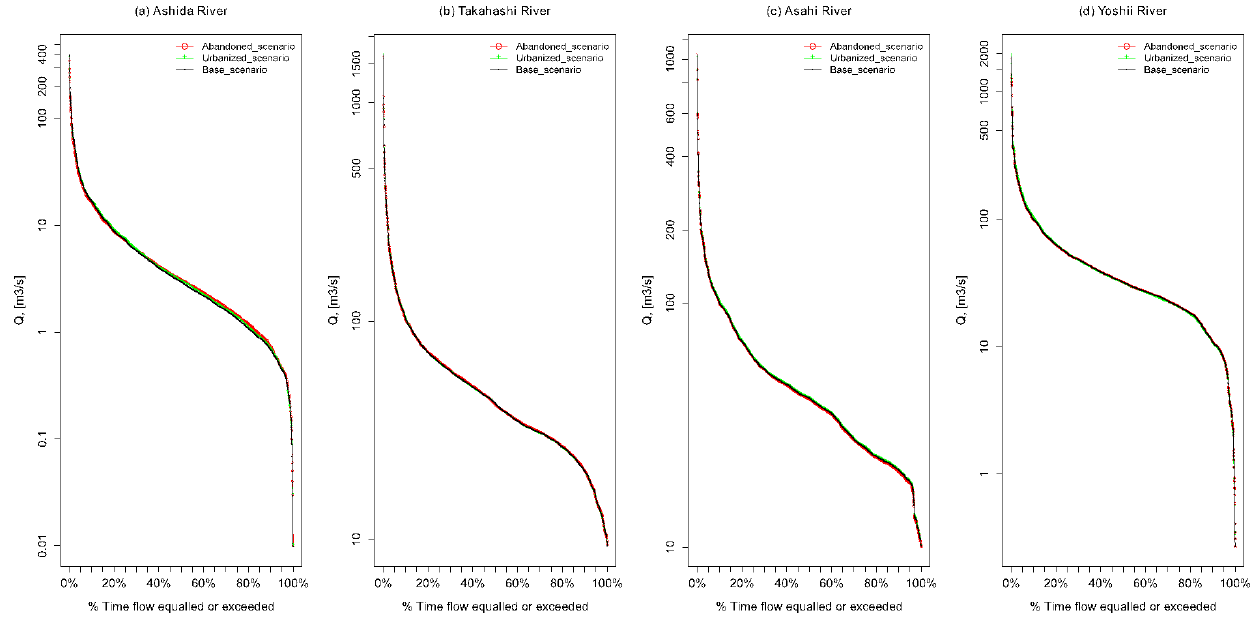
Figure 2. Flow duration curves of each scenarios. (a) Ashida River, (b) Takahashi River, (c) Asahi River, (d) Yoshii River.